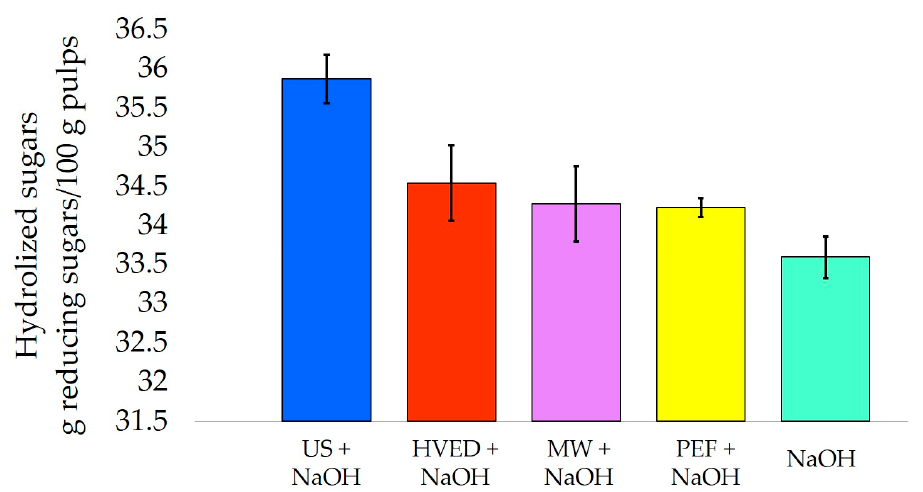
Figure 5. Effect of combined treatment (NaOH sol. (control), Pulsed electric fields (PEF) + NaOH sol., HVED + NaOH sol., US + NaOH sol., MW + NaOH sol.) on sugar recovery after 24 h of enzyme hydrolysis (NaOH sol. conditions: 60 ◦ C, 2 h, 0.3 molL − 1 , physical treatment condition: 30 min of total solid/liquid contact time (150 kJ kg − 1 for PEF and HVED, 1500 kJ kg − 1 for